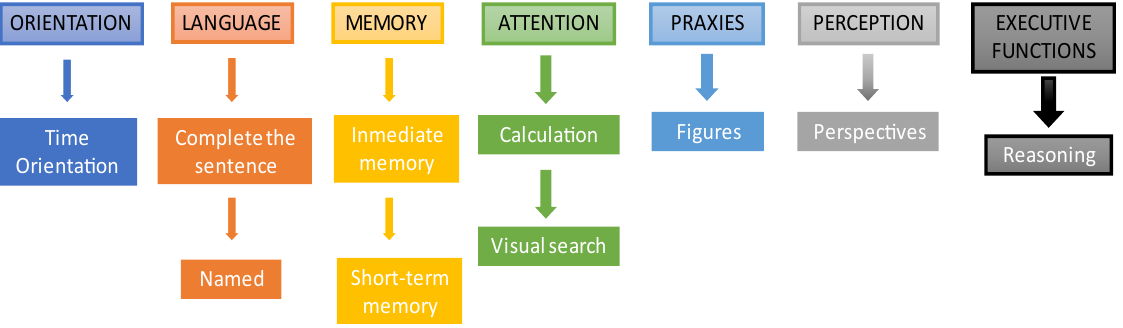
Figure 2. Cognitive areas and exercises of the NNCT test. The picture shows the exercises associated with each cognitive area in the order in which they are presented in the test.